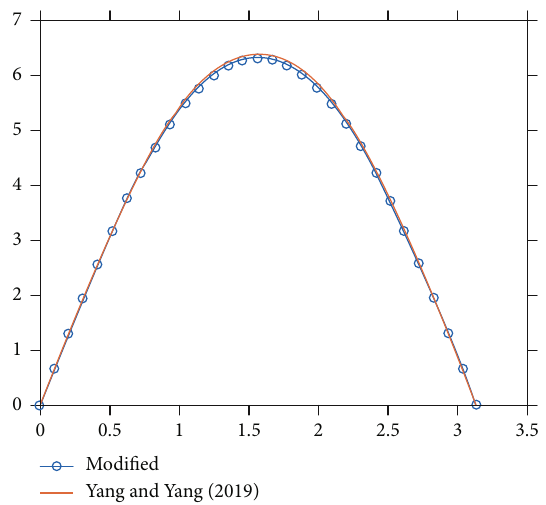
Figure 10: The variations of the system of equation (35) and the solution of the regularized system of equations (12) – (15) for p = 2 , k = 0 : 5 , α = 0 : 03 , and y = 1 .